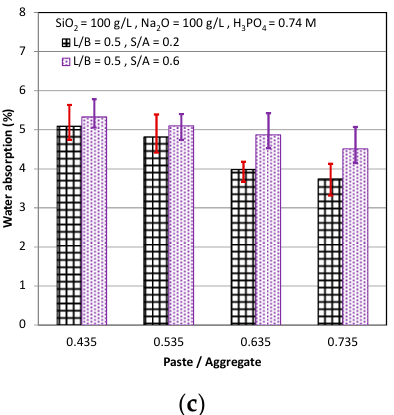
Figure 3. Water absorption: ( a ) P/A = 0.635, L/B = 0.5; ( b ) P/A = 0.635, S/A = 0.2 & 0.6; and ( c ) L/B = 0.5, S/A = 0.2 & 0.6.